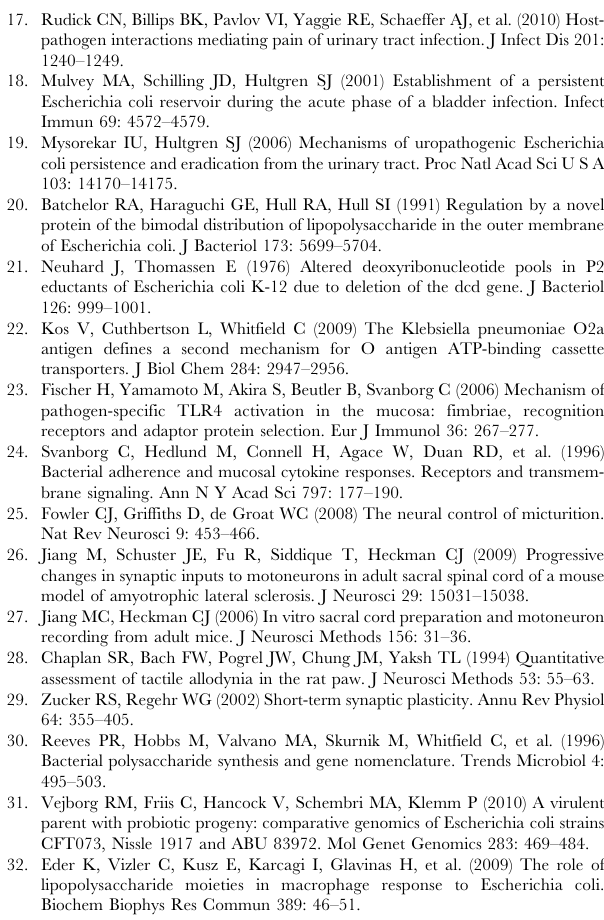
Table S4 In silico identification of 83972 LPS core. BLAST analyses with conserved primer sequences known to identify E. coli sequences identified homologous sequences representing the R1 core. The region ‘‘amplified’’ in silico was 547 bp and corresponded to a known R1 core enzymatic function, gylcosyl